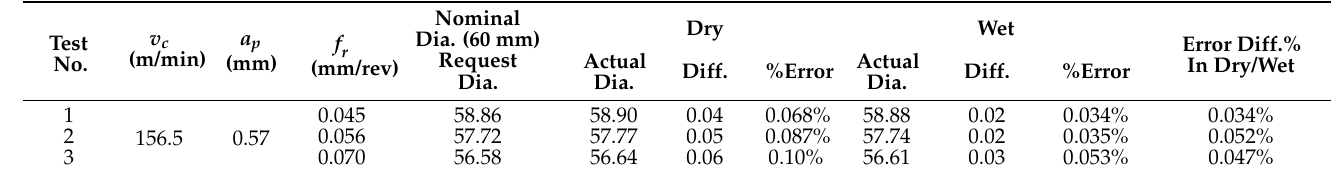
Table 8. Effect of dry and wet conditions on dimensional